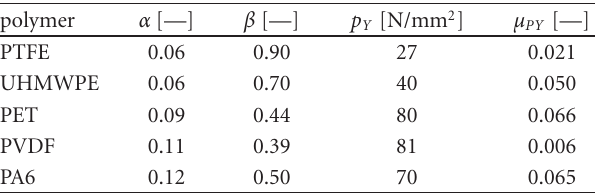
Table 2: Coe ffi cients of the friction model. Equation (9): exponen- tial terms α and β , and material properties p Y and μ PY of the tested polymers determined by curve fitting the dimensionless friction plots of Figure